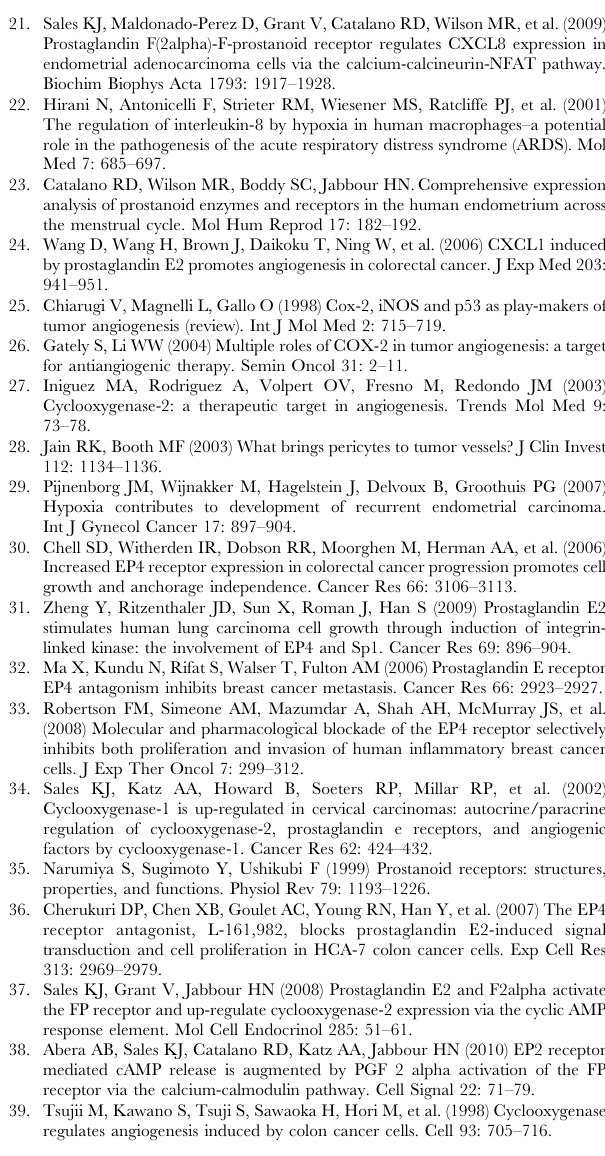
Figure S1 Expression profile of the PTGES-PTGER system in endometrial adenocarcinoma and normal endometrium. mRNA expression of PGE 2 synthase isoforms (PTGES, -2, -3) and E-series prostaglandin receptors (PTGER1–4) in normal endometrium (n =40; comprising of proliferative n= 10; early secretory n = 10; mid-secretory n =10 and late